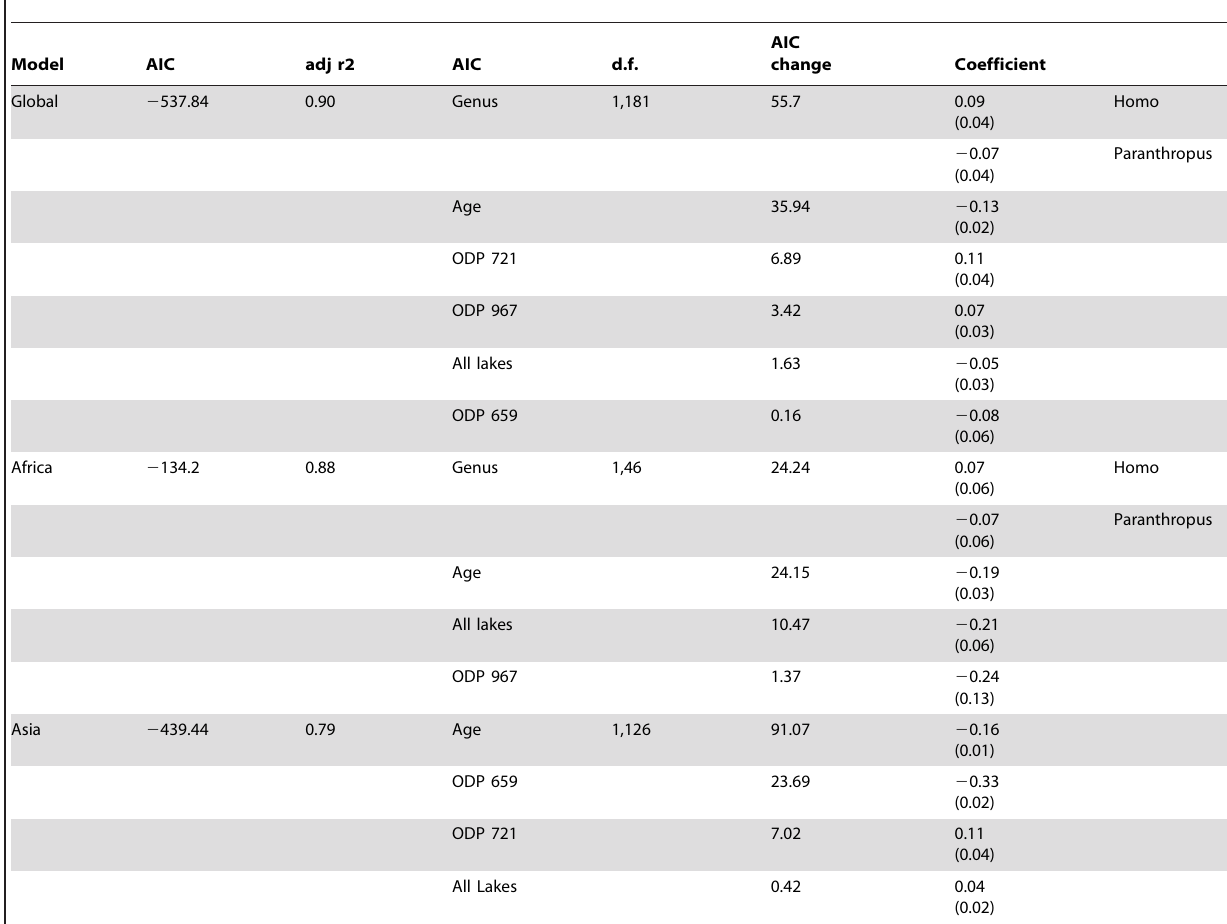
Table 3. The relationship between time and EARS lake coverage and encephalisation in hominins in Africa and Eurasia.